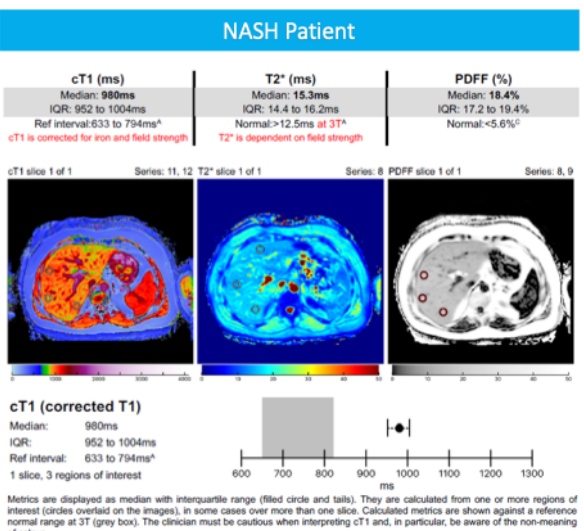
Figure 2. Sample reports that demonstrate the information that can be derived from the use of mpMRI to aid as a diagnostic tool for clinicians, highlighting the differences between a healthy patient with low cT1 and a patient with suspected nonalcoholic fatty liver disease (NAFLD) and high cT1. PDFF: proton density fat